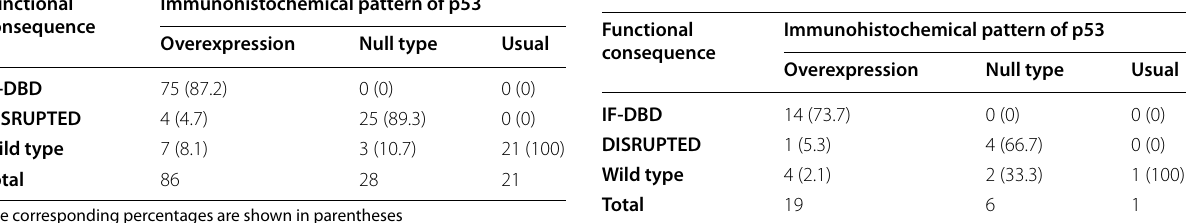
Table 4 Immunohistochemical staining patterns and predicted functional consequence of TP53 mutations within cases with previous neoadjuvant